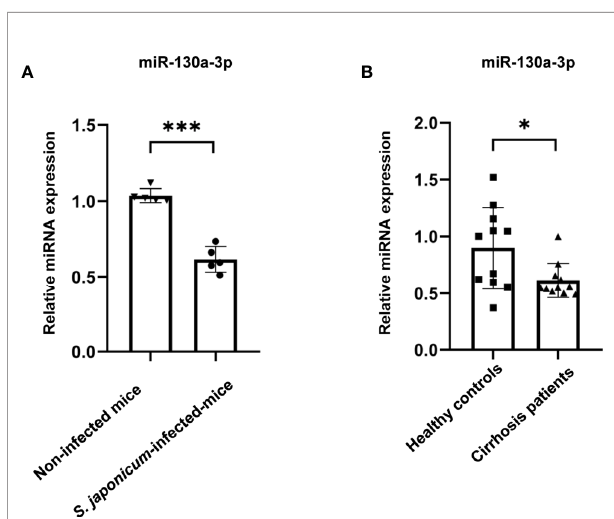
FIGURE 1 | Validation of the levels of miR-130a-3p in the livers of fi brotic mice and in the serum of fi brotic patients. The levels of miR-130a-3p in the liver of fi brotic mice and in the serum of cirrhosis patients were analyzed by quantitative real-time PCR (qRT-PCR). The expression of miR-130a-3p in S. japonicum -infected mice liver (A) and in serum of cirrhosis patients (B) . * p <0.01 and *** p <0.001 (n = 4 each